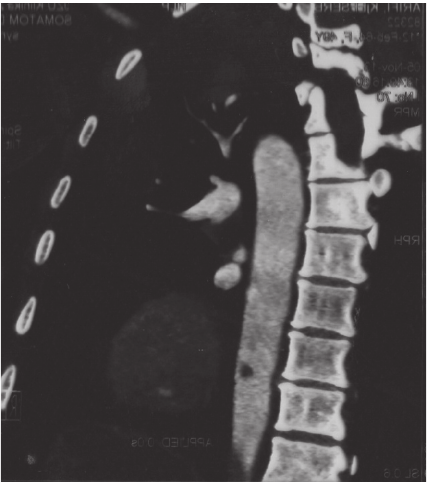
Figure 2: Thrombus in the descending